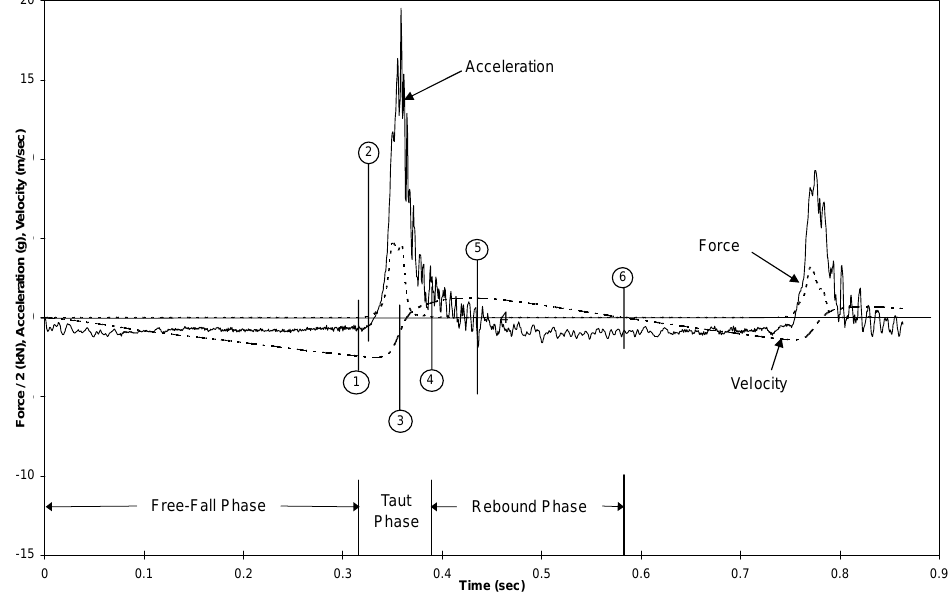
Fig. 4. Same test as in Fig. 3, showing two taut phases; velocity